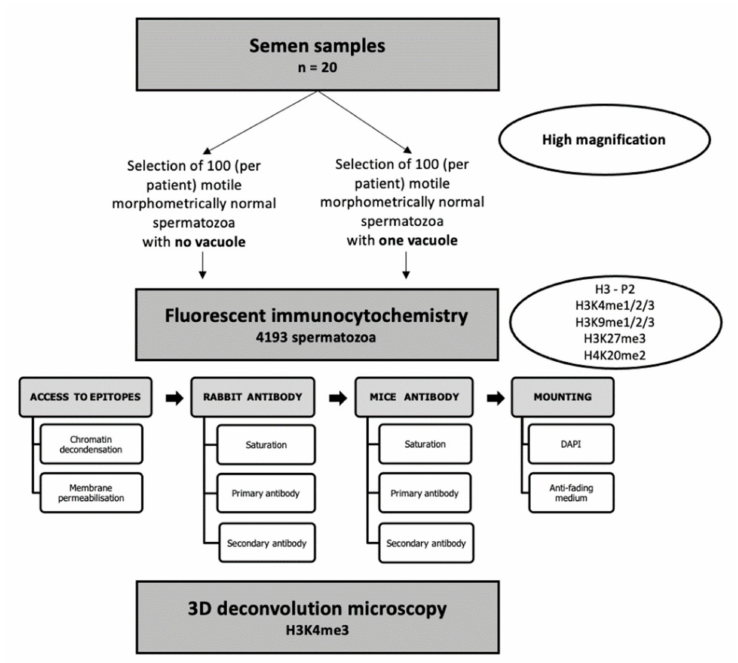
Figure 2. Summary diagram of the experimental